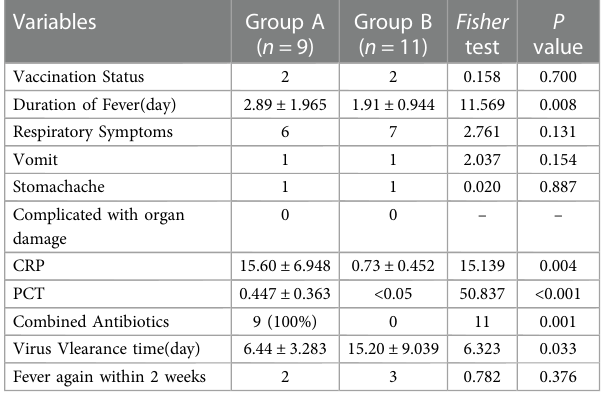
TABLE 5 Comparison of clinical manifestations and laboratory test results of two groups infected with novel coronavirus.